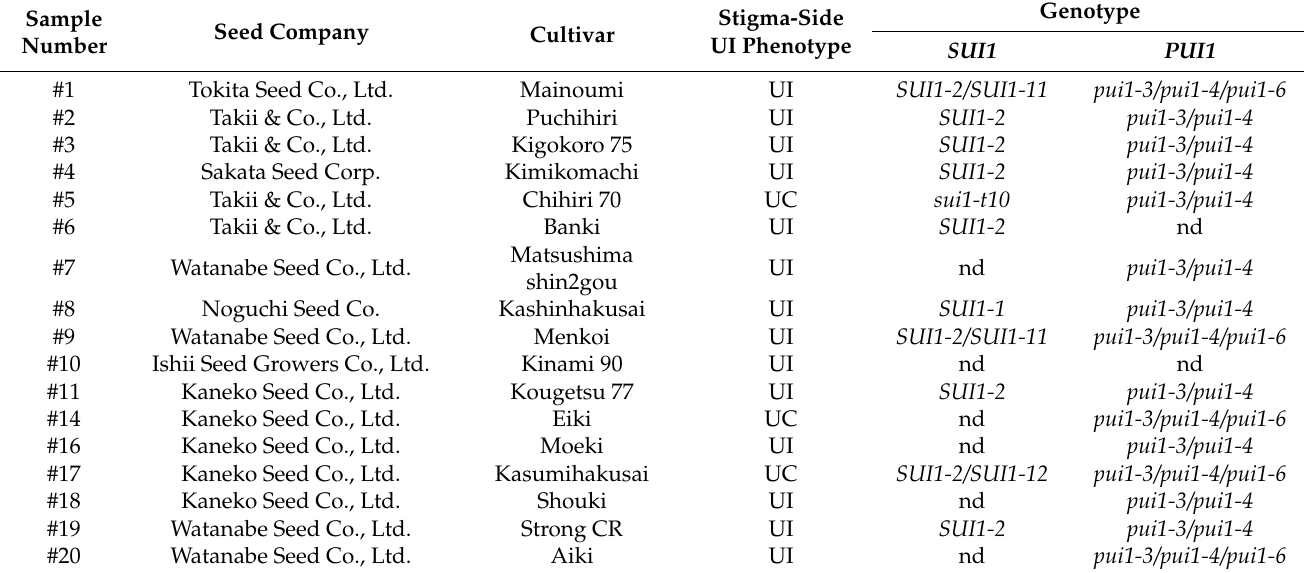
Table 1. UI phenotype and genotype of Japanese cultivars of Chinese